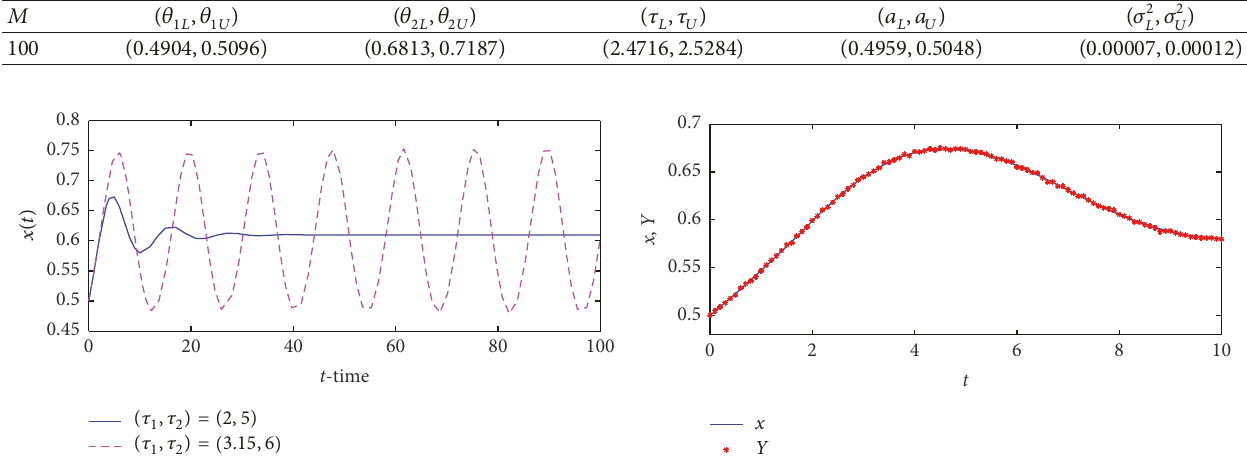
Table 6: Table showing the 95 % confidence intervals for parameters 𝜃 1 ,𝜃 2 , 𝜏, 𝑎 , and 𝜎 2 in DLDE with single delay. 𝑀